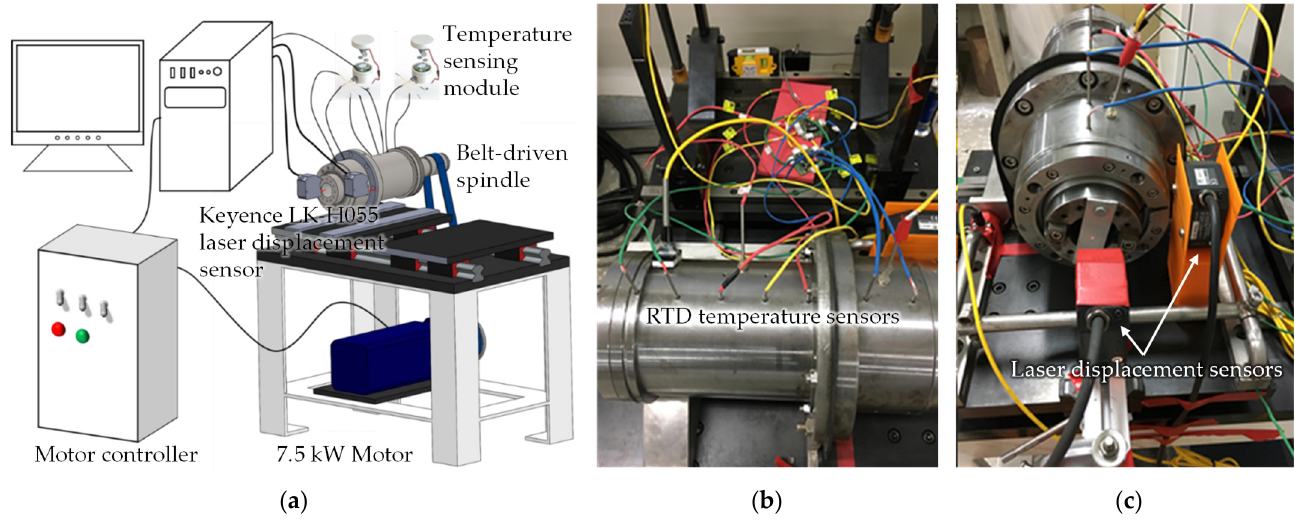
Figure 1. The spindle running-in experiment setup: ( a ) the scheme of the spindle running-in setup [15], copyright authorization has been obtained; ( b ) the side-view photograph of the spindle and the temperature measurement RTD; ( c ) the front-view photograph of the front end of the spindle and the laser displacement sensors.